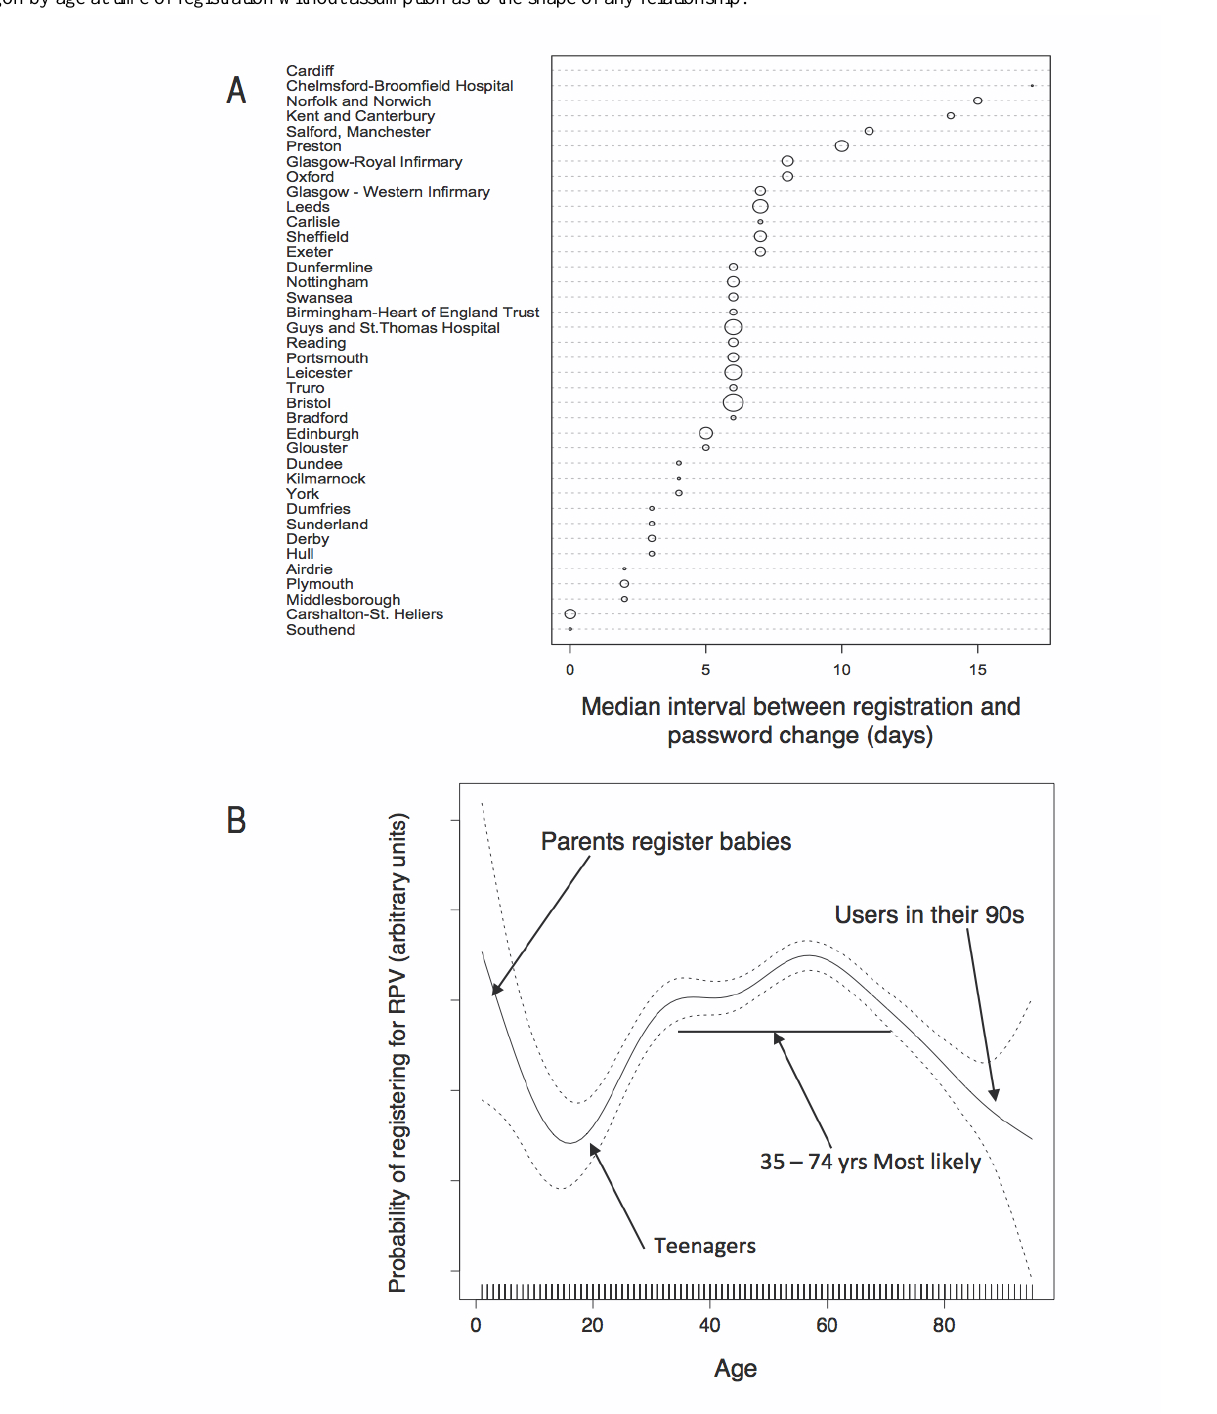
Figure 4. Interval from registration and likelihood of completing first logon. A: the median interval in days between registration and initial patient logon by renal center. The size of markers is proportional to total number of registrants at each center. Two centers are remarkable for completing the process within a day for most patients (87% of patients at the larger center). B: Probability of completing first logon by age. A logistic (completed first logon = T/F) general additive model (non-parametric) was constructed using the mgcv package to model the likelihood of patients completing first logon by age at time of registration without assumption as to the shape of any